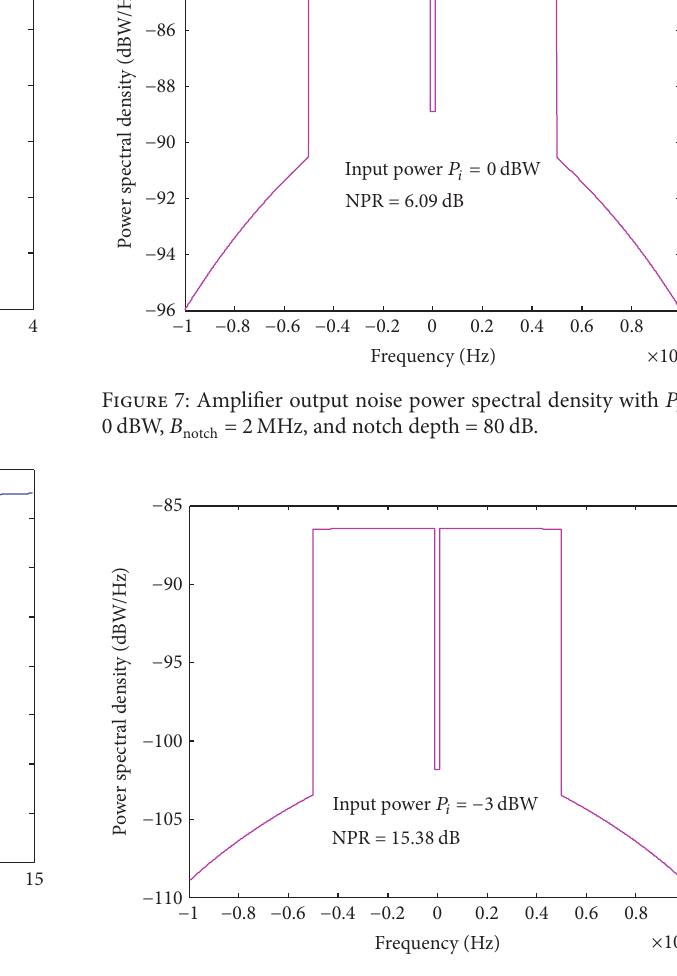
Figure 8: Amplifier output noise power spectral density with 𝑃 𝑖 = −3 dBW, 𝐵 notch = 2 MHz, and notch depth = 80